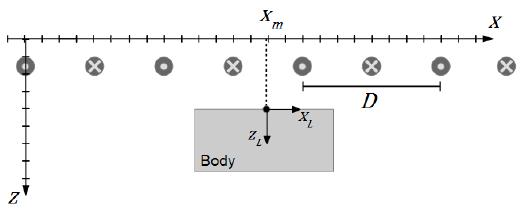
Figure A2. Body with local coordinates and at arbitrary position x m in front of the Figure A2 . Body with local coordinates and at arbitrary position 𝑥 𝑚 in front of the undulator